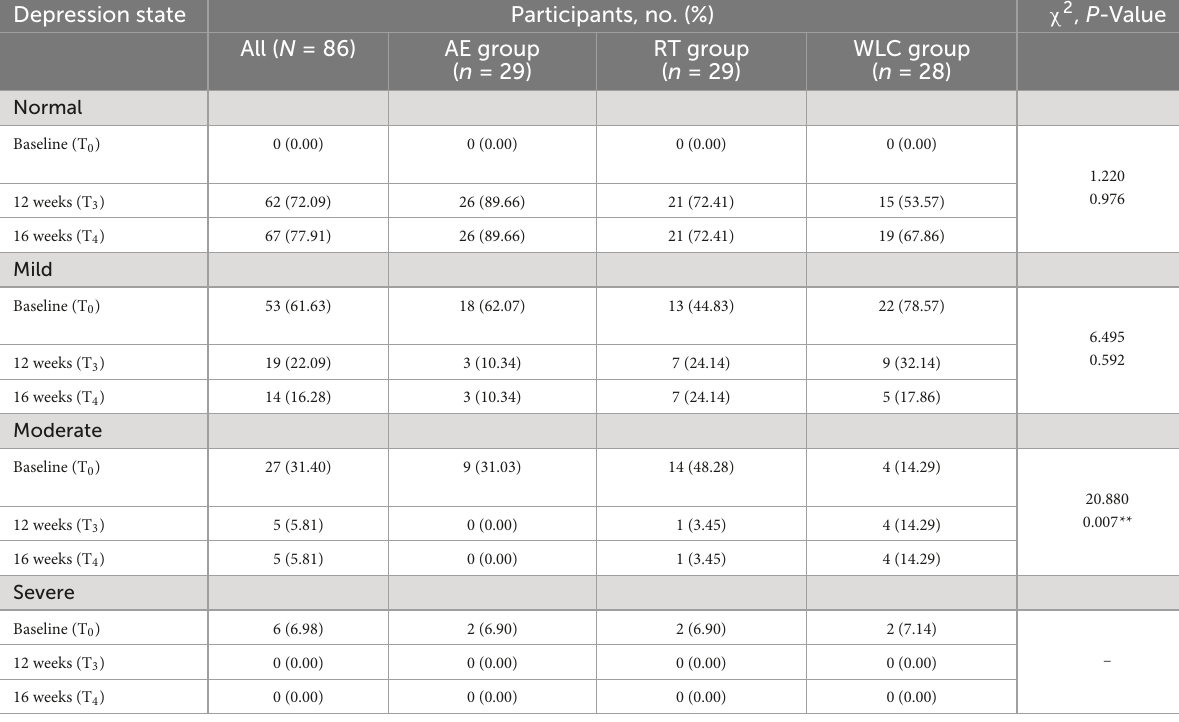
TABLE 6 Numbers of participants with different depression levels in AE, RT, and WLC groups. Depression